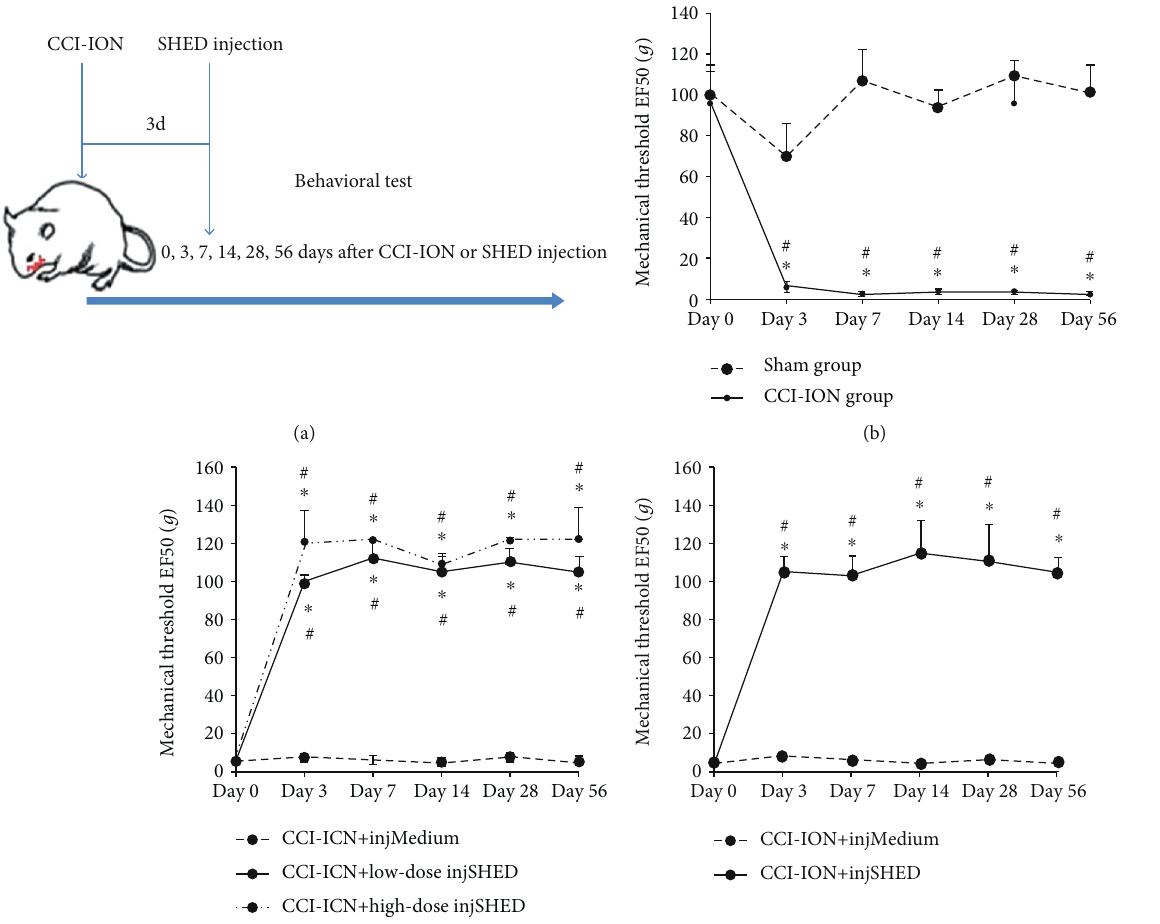
Figure 2: E ff ect of SHED transplantation on neuropathic pain. (a) Scheme showing the timing of SHED transplantation and behavioral testing. (b) The mechanical threshold was signi fi cantly decreased in CCI-ION rats. (c) Changes in the mechanical threshold after direct injection of low-dose ( 1 × 10 5 cells, 0.2mL, CCI-ION+low-dose injSHED group) or high-dose ( 1 × 10 6 cells, 0.2mL, CCI-ION+high-dose injSHED group) SHED into the site of injury were measured for 56 days in CCI-ION rats. Local injection of medium (CCI-ION +injMedium group) was used as a control. (d) Changes in the mechanical threshold after infusion of SHED ( 1 × 10 5 cells, 0.2mL, CCI- ION+infSHED group) through the tail vein were measured for 56 days in CCI-ION rats. Infusion of medium (CCI-ION+infMedium group) was used as a control. ∗ p < 0 : 05 vs. sham (b), ∗ p < 0 : 05 vs. medium (c, d), and # p < 0 : 05 vs. day 0. All data are expressed as the mean ± SEM ( n = 6 rats in each